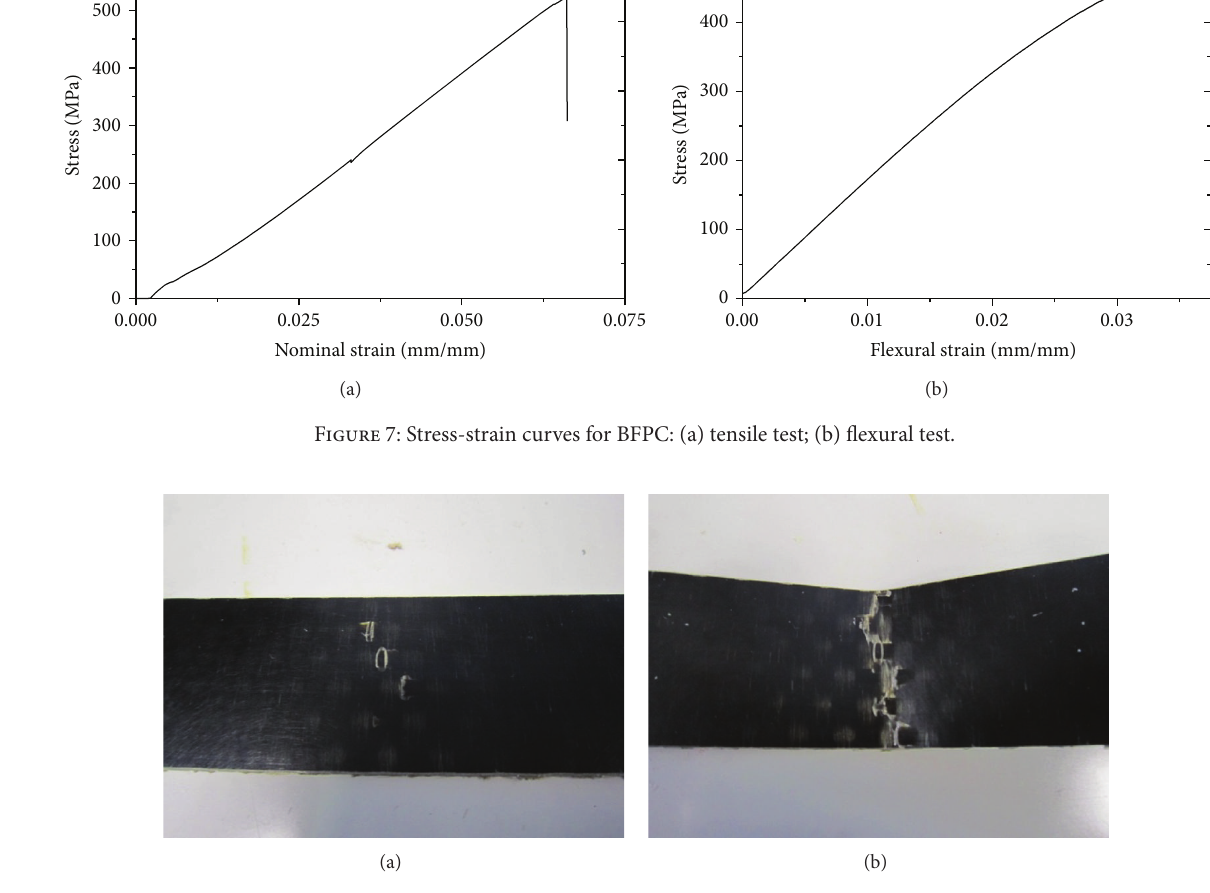
Figure 8: Successive stages of BFPC compressive failure in flexural tests.